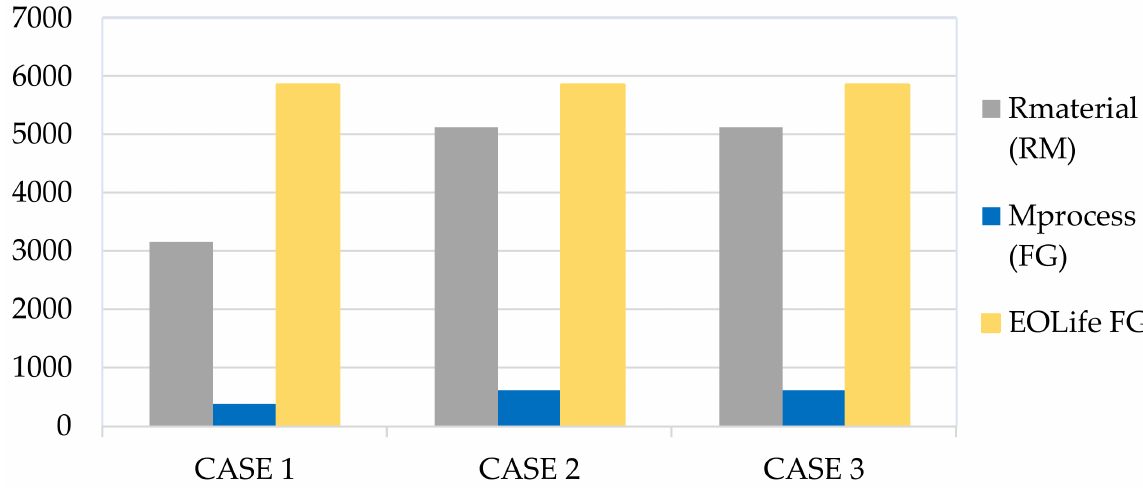
Figure 12. Total CO 2e generated due to waste management (t of CO 2e